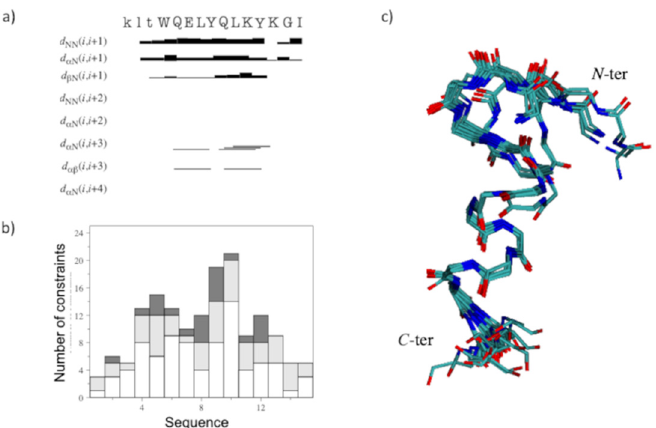
Figure 3. ( a ) D-QK NOEs diagram in water. The amino acid sequence is reported on the top. Principal sequential and medium-range NOEs are shown; the thickness of each block is proportional to the corresponding NOE intensity. ( b ) Number of constraints per residue. White, light gray and dark gray bars indicate intra-residue, sequential, and medium-range connectivities, respectively. ( c ) Superposition of the minimized 20 best structures represented as neon (RMSD (N, Ca, C’(5–12) = 0.37 ± 0.05 Å). N-ter and C-ter refer to the amino and carboxyl termini, respectively.